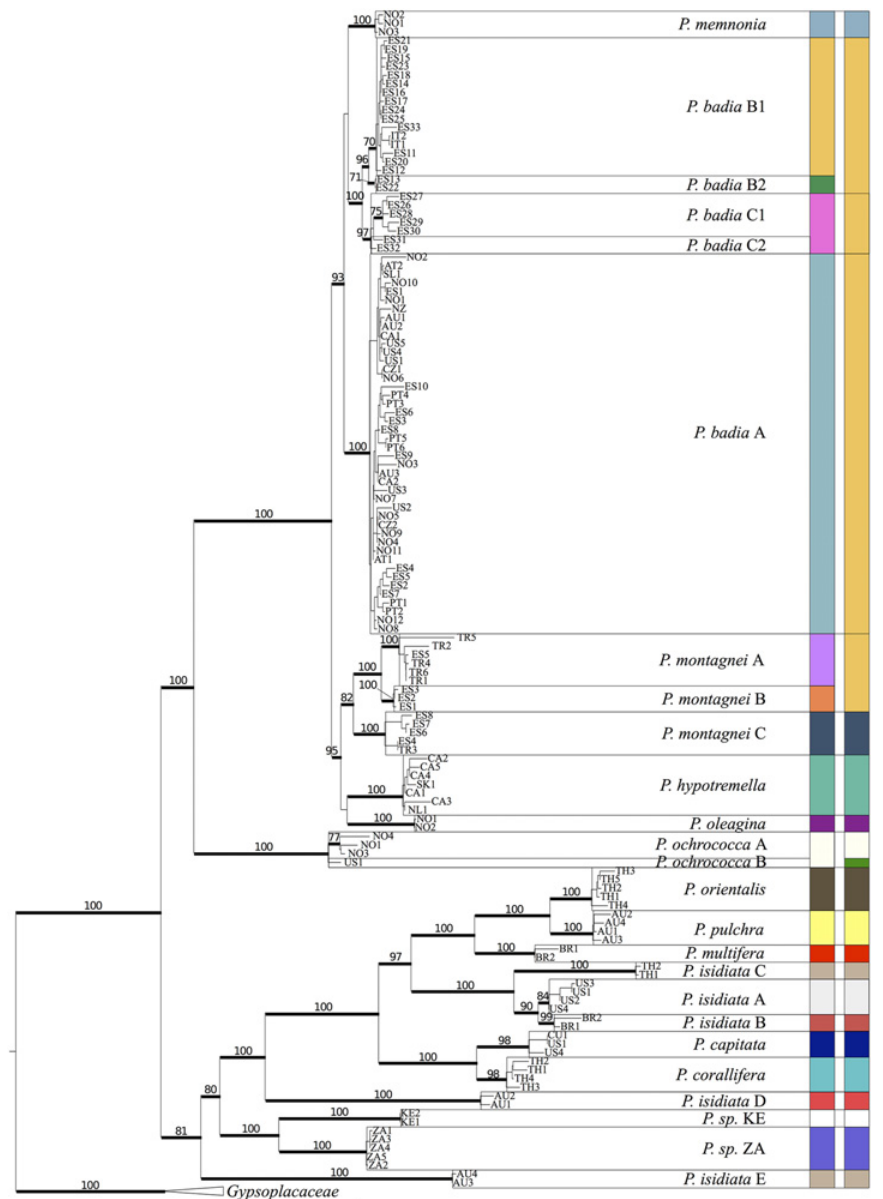
Fig 2. Phylogeny of Protoparmelia s . str . based on six concatenated loci. Numbers above branches indicate ML BS (cid:1) 70%. Branches in bold indicate Bayesian posterior probabilities (PP) (cid:1) 0.94. Specimen indicators include country codes (see Supporting information S1 Table). Taxon names refer to putative species supported by ML BS (cid:1) 70% or Bayesian Inference (PP (cid:1) 0.94), and tested for speciation probabilities using BP&P and spedeSTEM. Colored boxes indicate species supported by BP&P (left) and spedeSTEM (right),